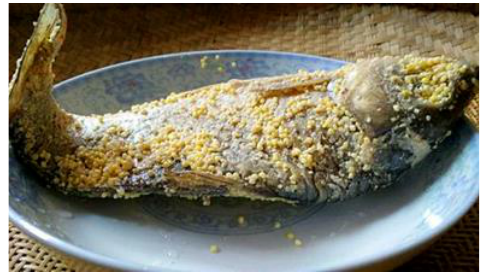
Figure 1. Suanyu samples after fermentation. A total of 16 Suanyu samples were analyzed. The entrails, spines, and scales were removed and the carp meat was mixed using a blender and frozen at − 80 ◦ C (Haier, DW-86L338J, Qingdao, China) for further